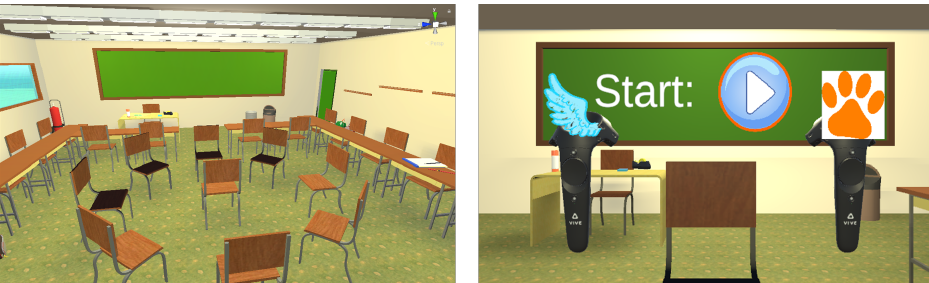
Figure 1. Images of the virtual environment. Left : Virtual classroom with the participant’s chair surrounded by a circle of chairs and basic classroom furniture. Right : View from the participant’s position in the virtual environment facing the blackboard and the virtual controller